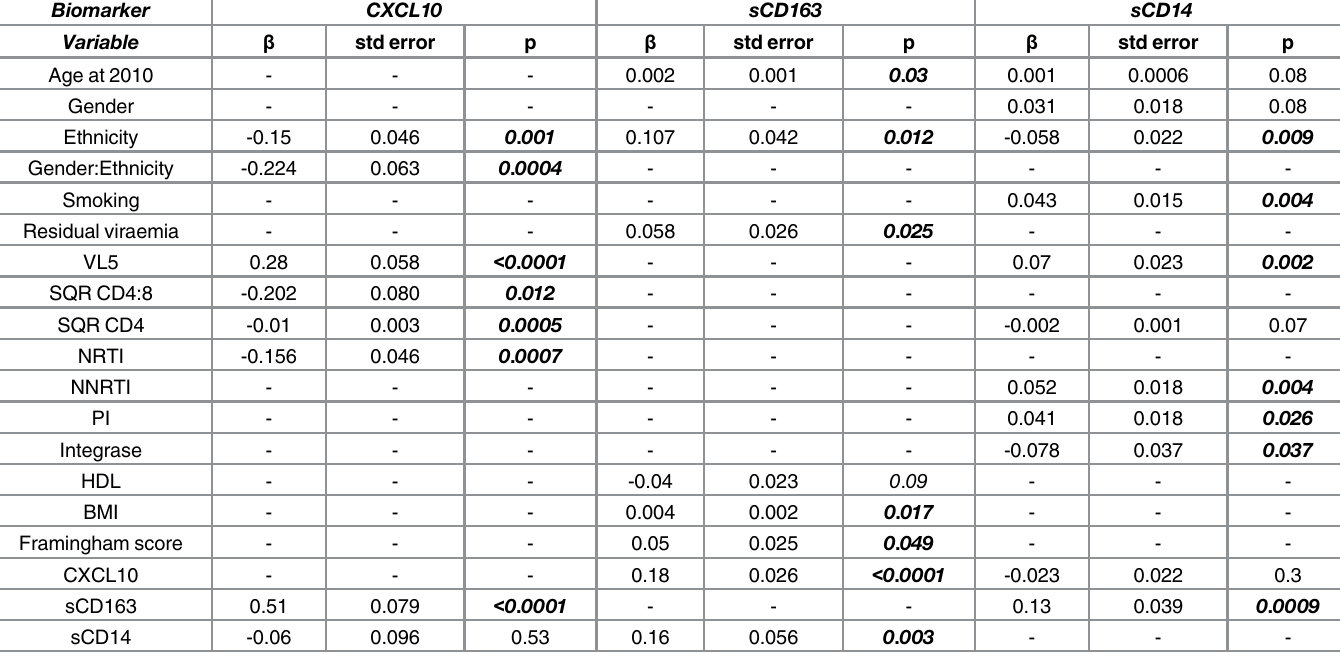
Table 2. Model 2 — Multivariate regression results showing significant associations of plasma biomarker with HIV clinical parameters, CVD risk age, gender, ethnicity and smoking after adjusting for CXCL10, sCD163 and sCD14.